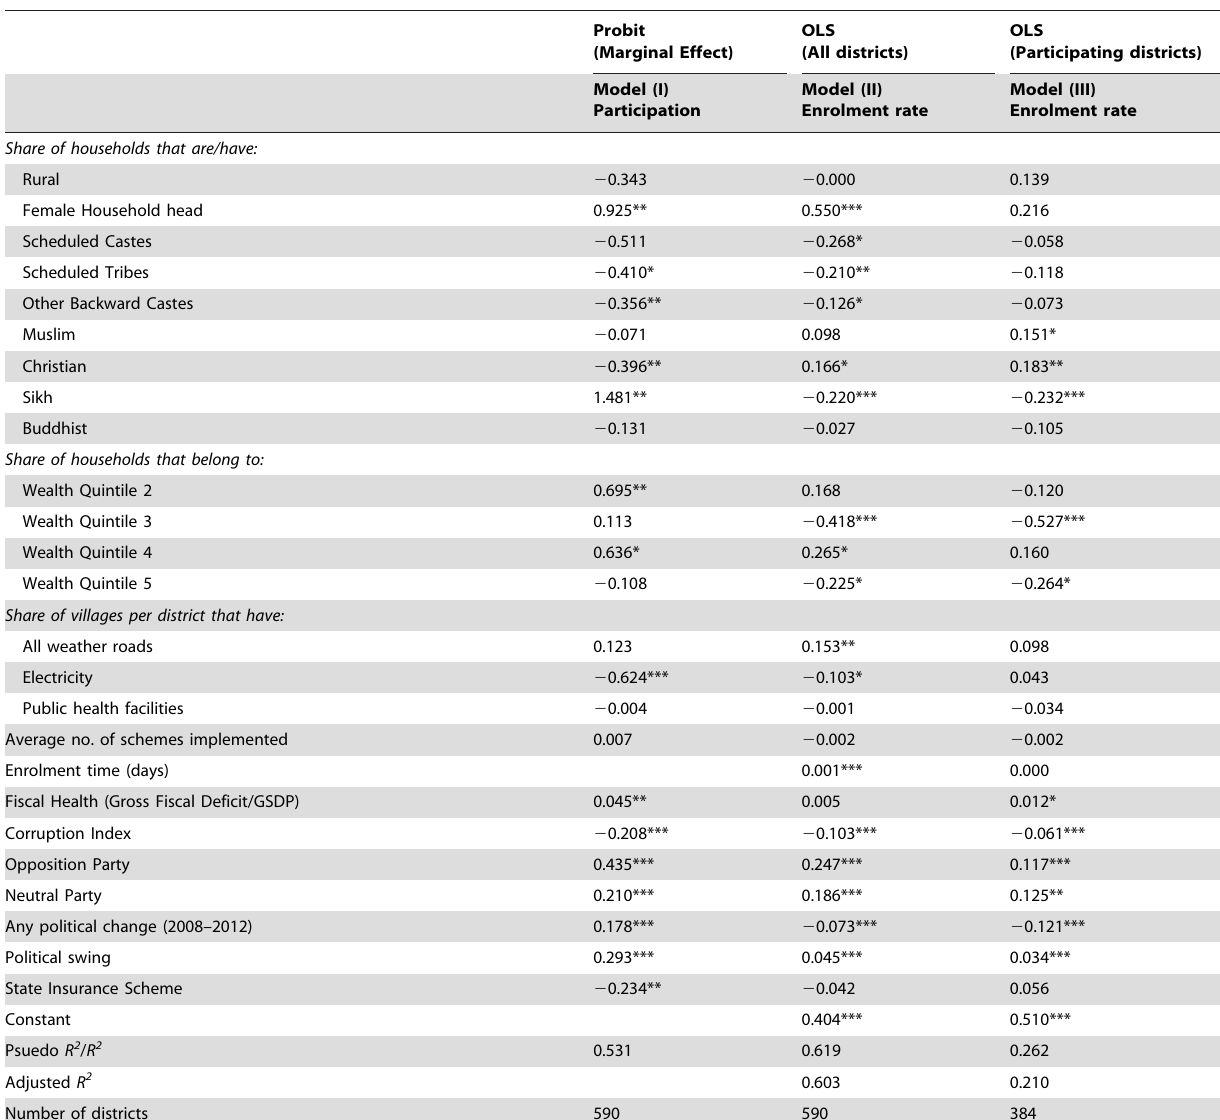
Table 4. RSBY Participation and Enrolment rate regression